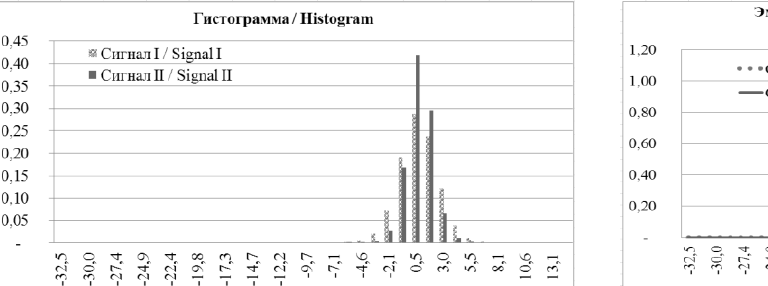
Fig. 12. Empirical functions of distribution for signals I and signals